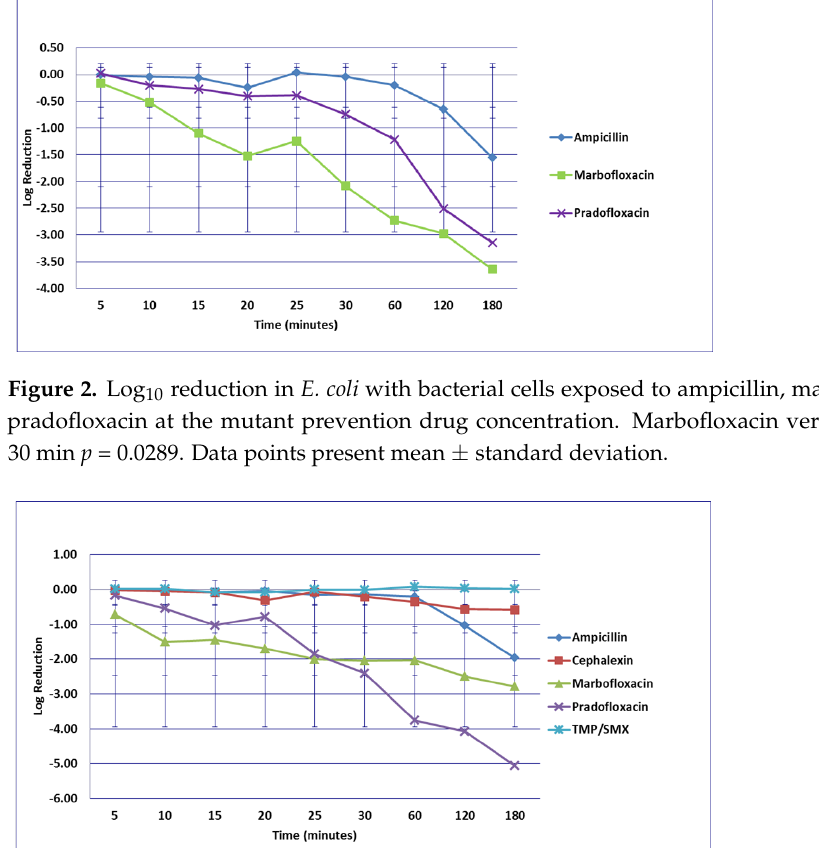
Figure 3. Log 10 reduction in E. coli with cells exposed to ampicillin, cephalexin, marbofloxacin, pradofloxacin, and trimethoprim/sulfamethoxazole at the maximum serum drug concentration. *Pradofloxacin vs. TMP/SMX at 60, 120, and 180 min, p values = 0.0136, 0.0234, 0.0211. Marbofloxacin vs. TMP/SMX at 120, 180 min, p values = 0.0269, 0.0218. TMP/SMX vs. ampicillin at 180 min, p value = 0.0300. Data points present mean ± standard deviation.